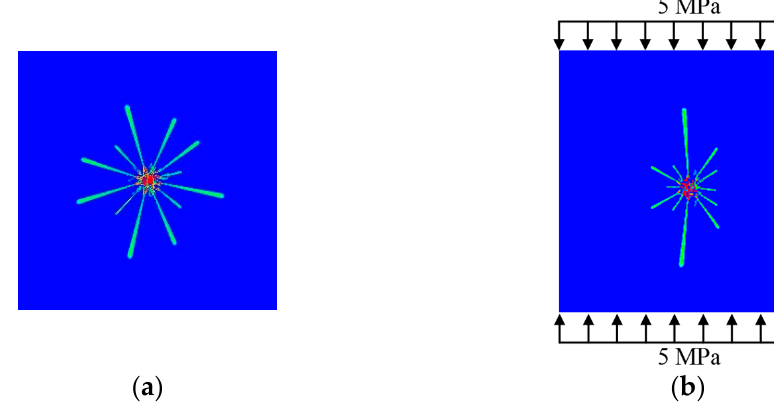
Figure 4. Numerical modeling of rock fracture caused by single-hole blasting: ( a ) without initial stress; ( b ) with a uniaxial stress of 5 MPa.